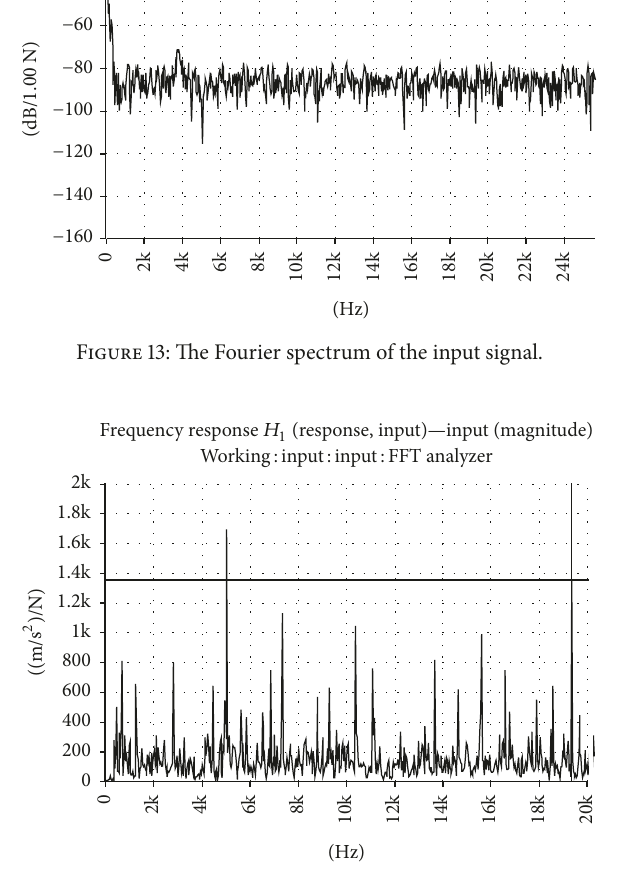
Figure 14: The frequency response function of the horn.